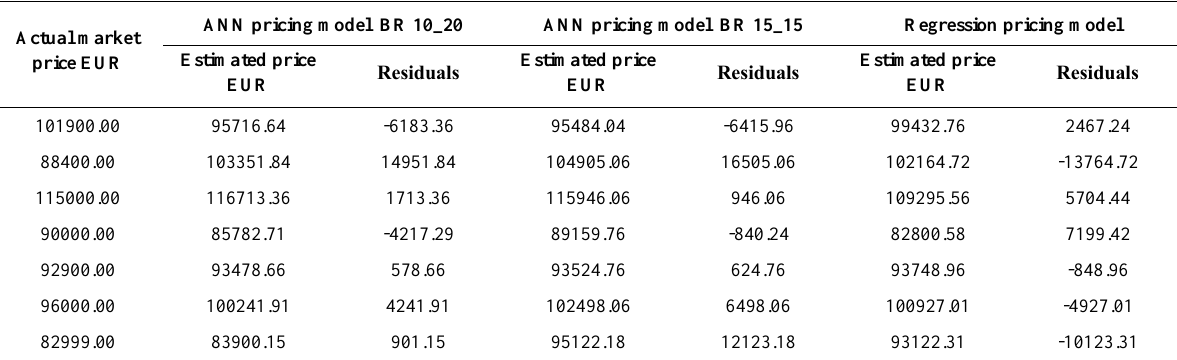
Table 7. Estimated property